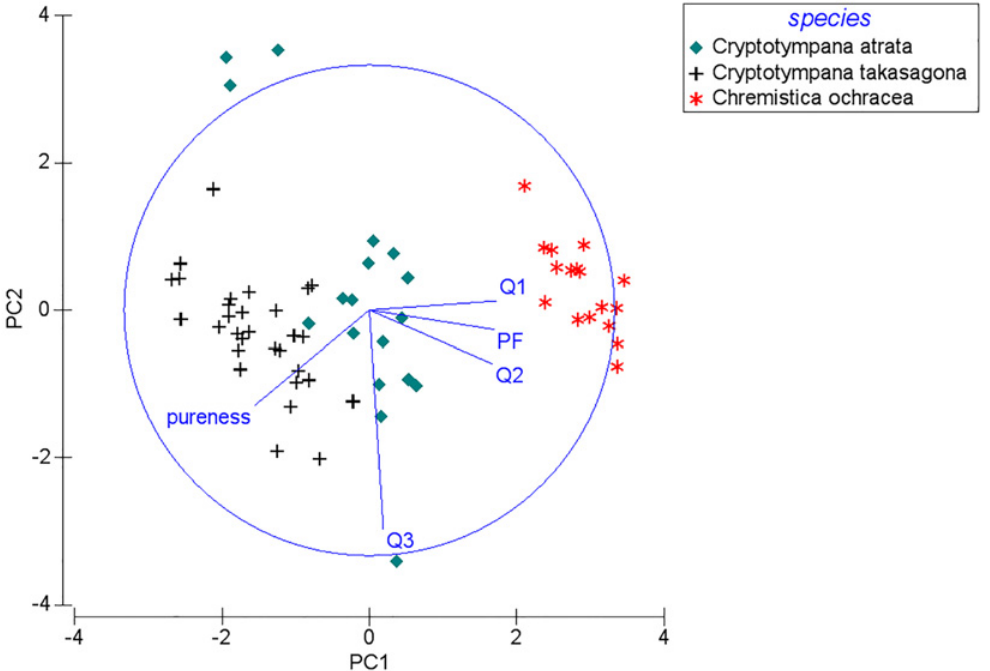
Figure 5. A bi-dimensional plotting of the principal component analysis using the five acoustic variables (PF, Q1, Q2, Q3, pureness) on spectrograms of cicada calling songs at the two city sites, CC and SO of